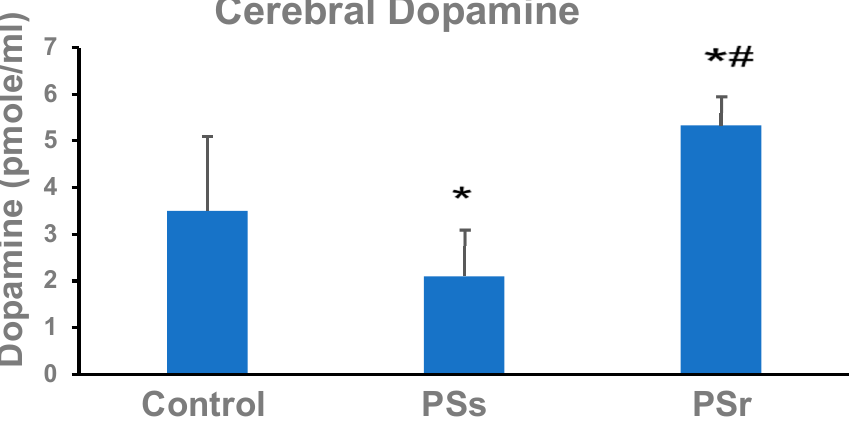
Figure 3. Effect of PS on dopamine concentration in brain parietal cortex of control rats (n = 19), PS-susceptible rats (PSs, n = 9), and PS-resilient rats (PSr, n = 11). * Difference from control, p = 0.025. # Difference from PSs, p < 0.001).